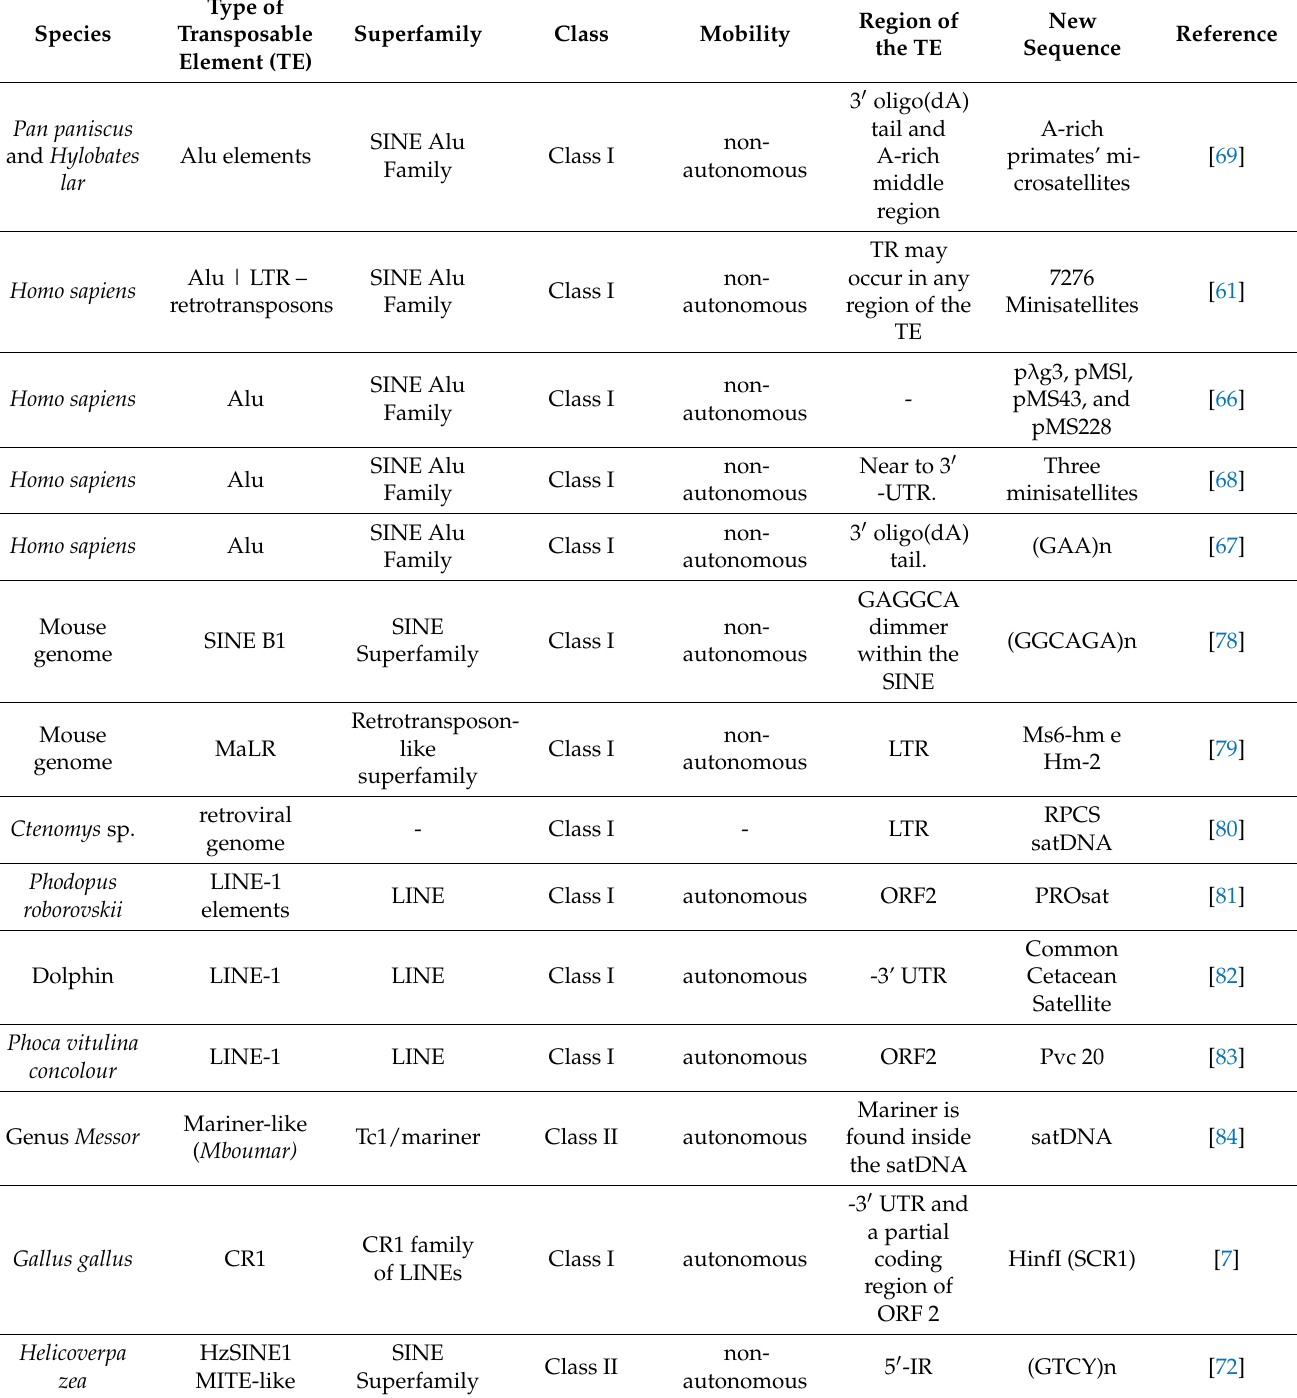
Table 1. Recorded cases of transposable elements giving rise to satellite, mini- and microsatellite DNA (satDNA), according to their mobility and the regions of the transposable elements that have given rise to the tandem repeat sequences. ORF (Open Reading Frame); TR (Tandem Repeat); UTR (Untranslated Region); LTR (Long Terminal Repeat), TIR (Terminal Inverted Repeats), IR (Inverted